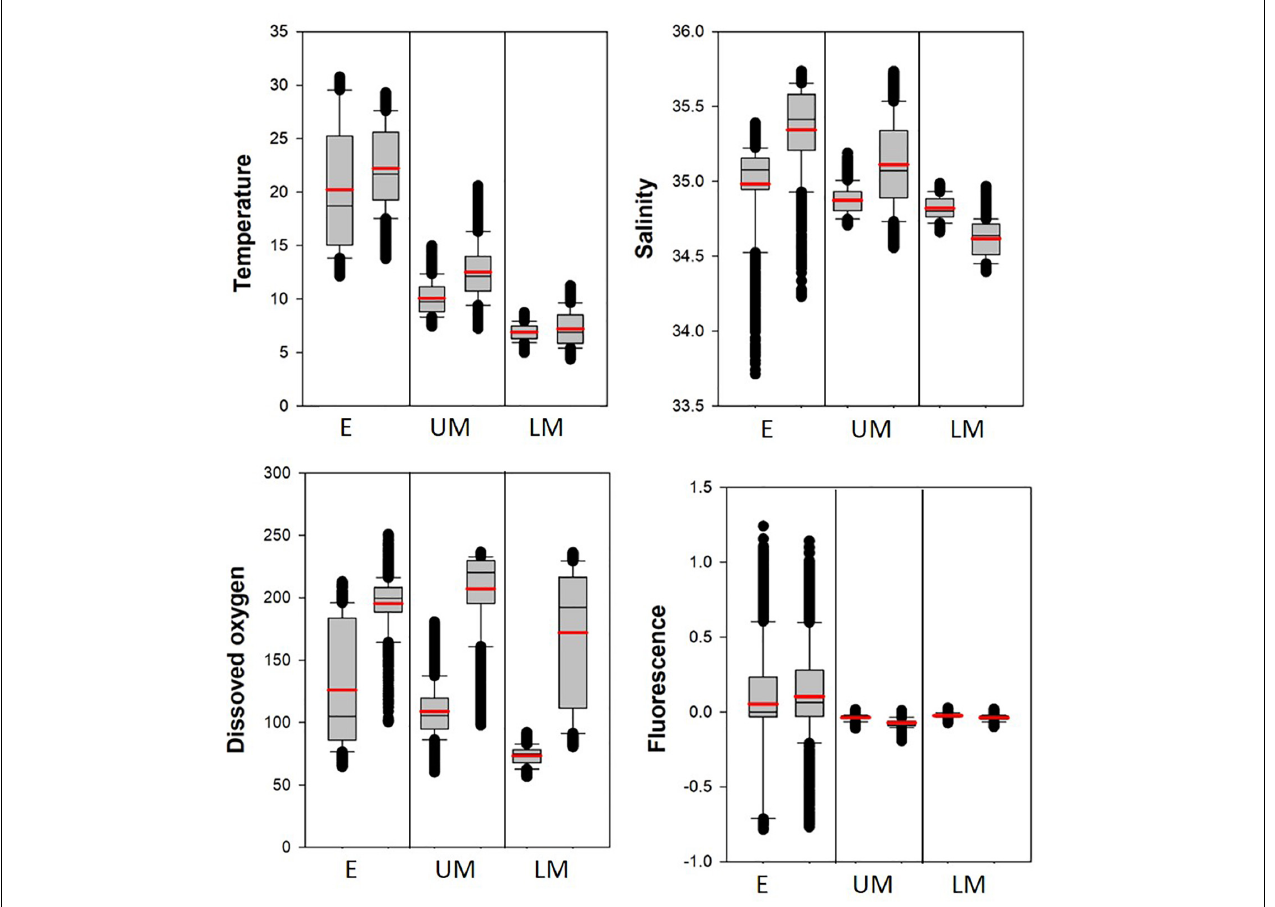
FIGURE 6 | Boxplots of the marine environmental properties in the depth layers (E, UM, and LM) in the SCTR (first box) and the non-SCTR (second box) regions. The mean value indicates the thick red line.